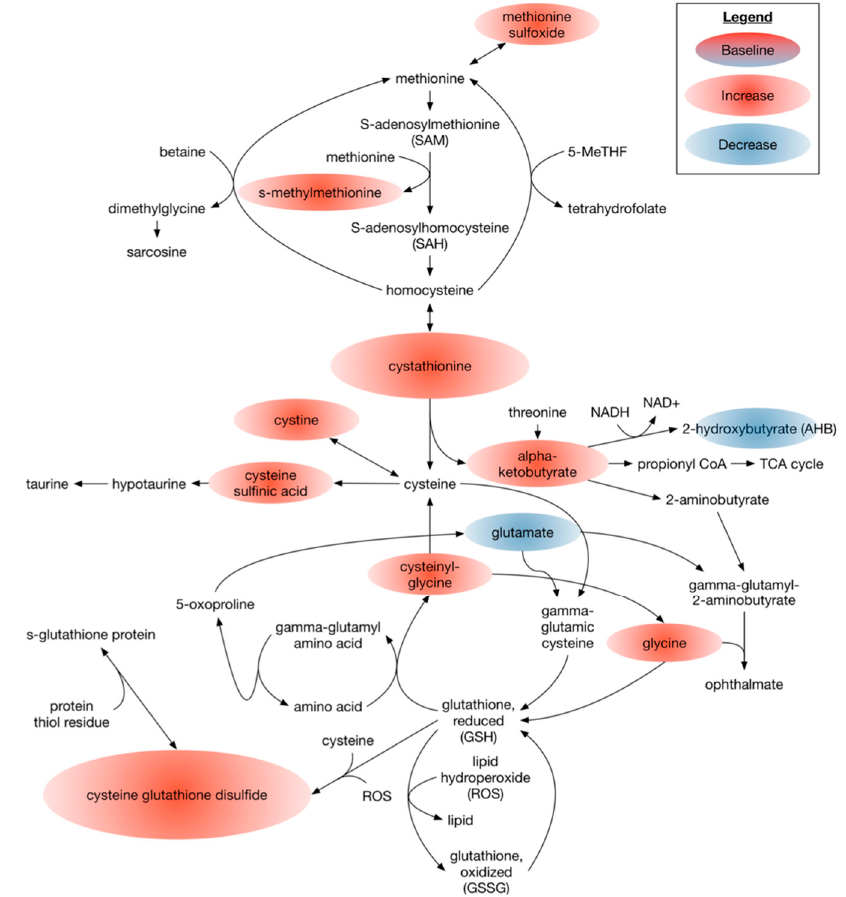
Figure 3. Changes in cysteine, methionine, and glutathione metabolism overlaid on a metabolic map. The size of each colored bubble is proportional to the fold change (increase, red; decrease, blue). The baseline bubble in the legend corresponds to a fold change of 1. 5-MeTHF, 5-Methyltetrahydrofuran-2-ol; NADH, nicotinamide adenine dinucleotide (NAD) + hydrogen (H); NAD, nicotinamide adenine dinucleotide; Propionyl CoA, propionyl coenzyme A; TCA cycle, tricarboxylic acid cycle. Table 4. Metabolites Related to Cellular Oxidative State.